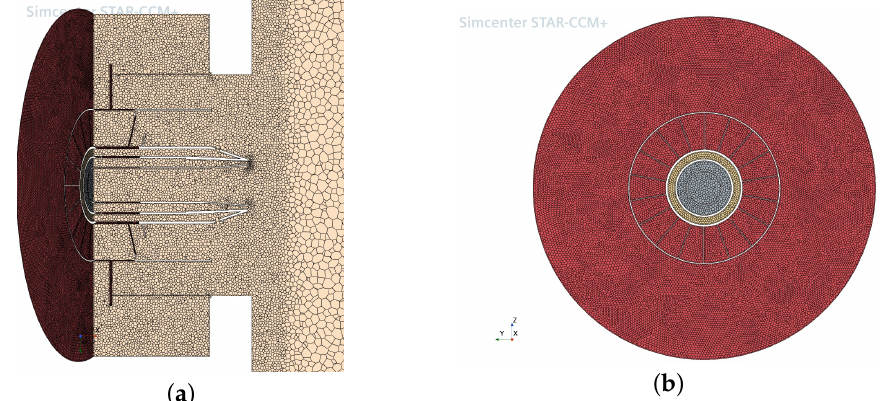
Figure 4. Calculation grid of the study area of the simulated burner: ( a ) burner cut; ( b ) front